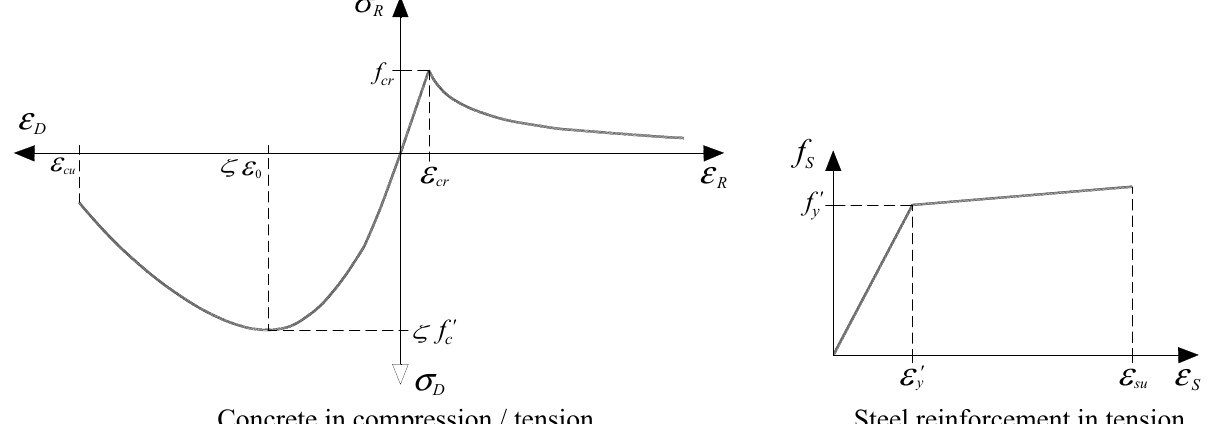
Figure 3. Smeared constitutive laws.